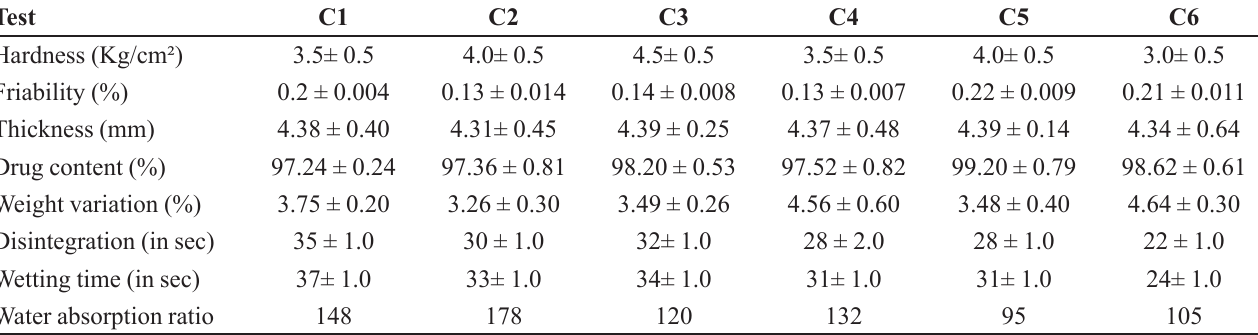
TABLE IV - Different evaluation parameters of granisetron hydrochloride ODT tablets (mean ± SD) n=3